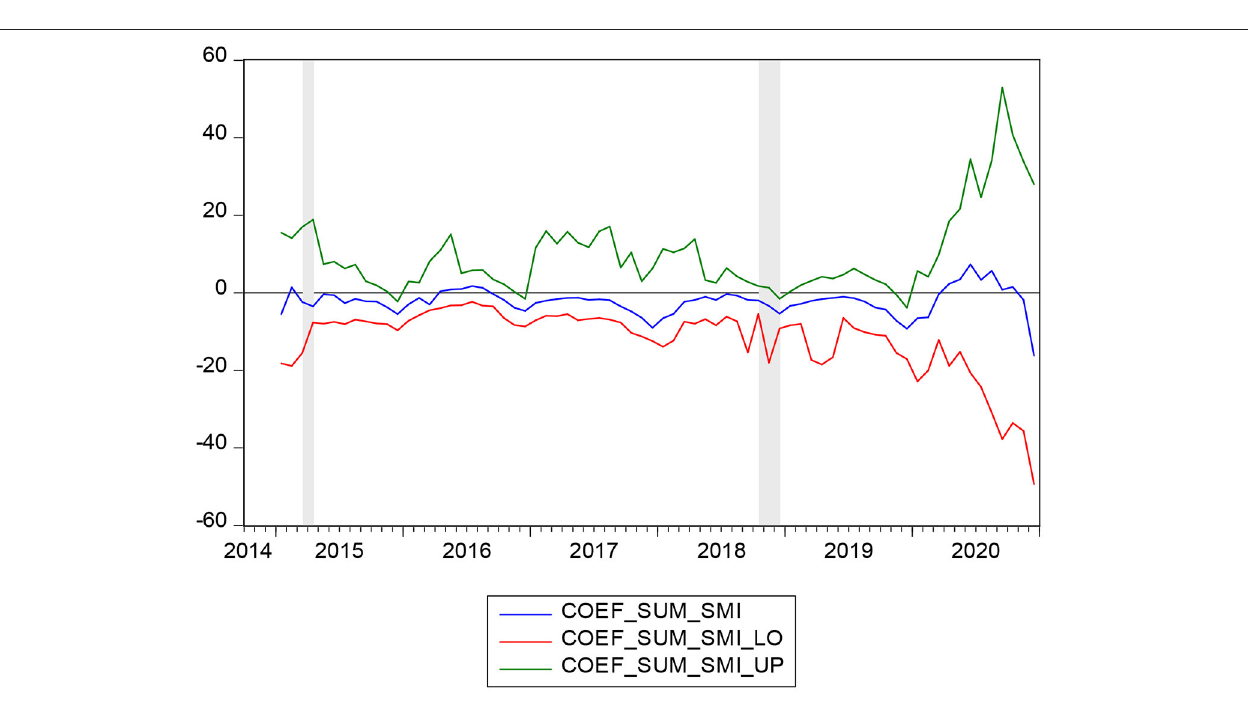
FIGURE 4 | Bootstrap estimates of the sum of the rolling-window coefficients for the impact of PR on